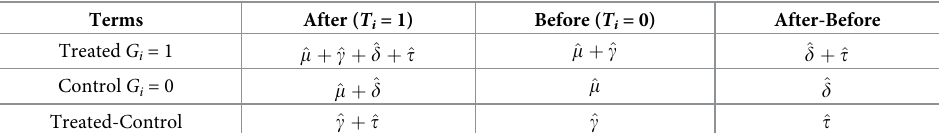
Table 1. Difference-in-difference